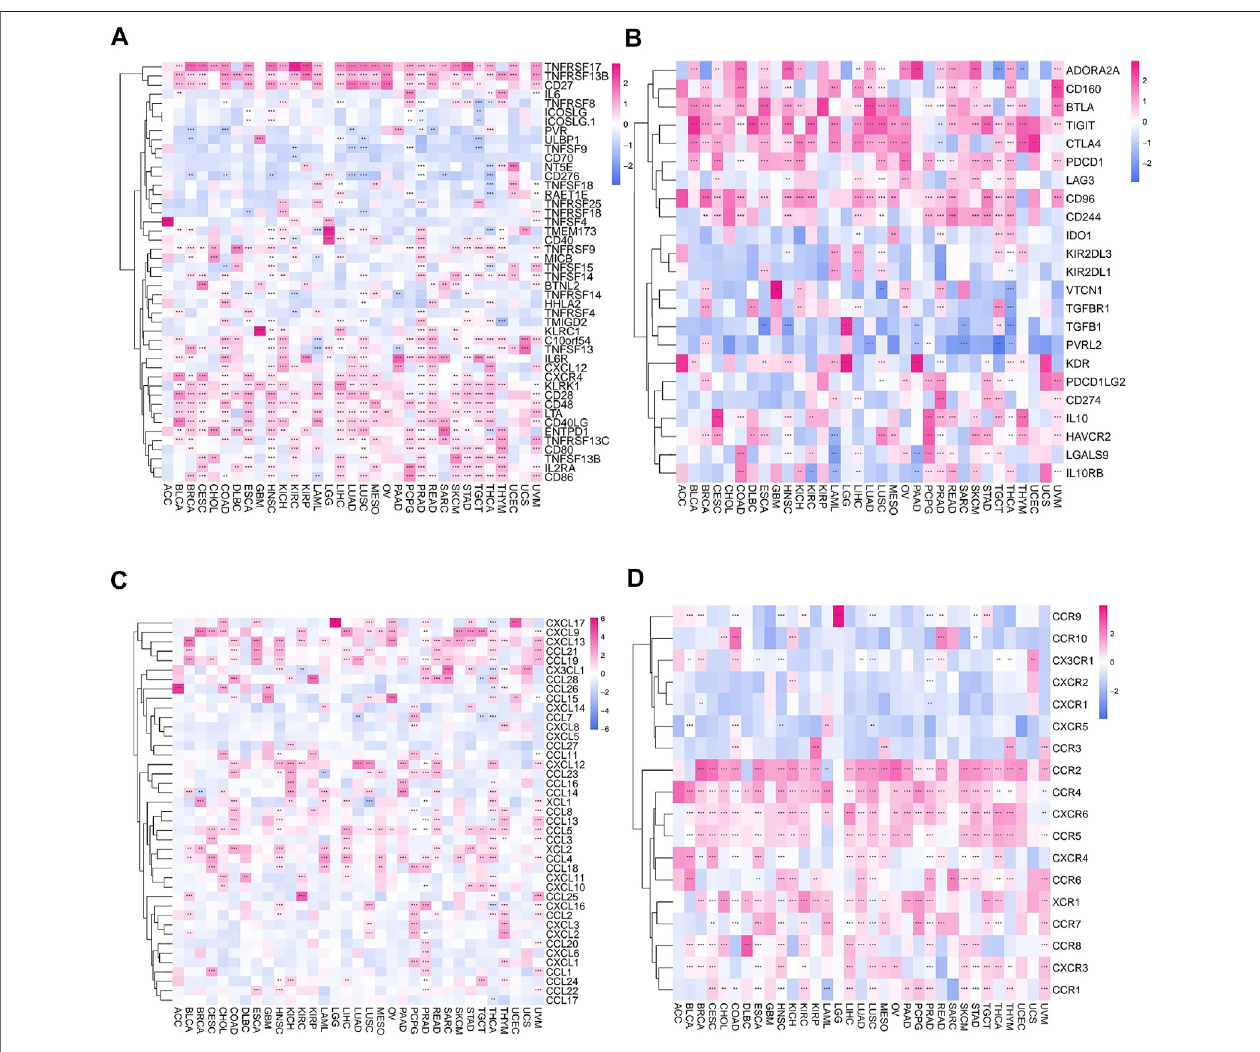
FIGURE 11 | Relationship between FAM46C expression and immune-related factors. Relationship between FAM46C expression and (A) immune activating genes, (B) immunosuppressive genes, (C) immune chemokines and (D) immune chemokine receptors (* p < 0.05, ** p < 0.01, *** p < 0.001).